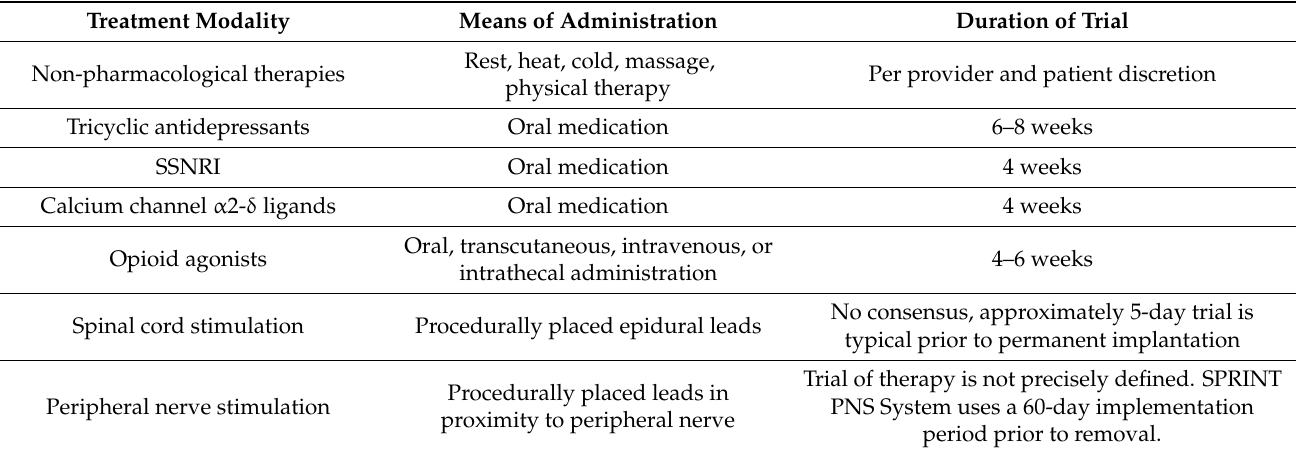
Table 1. A brief overview of treatment modalities for chronic